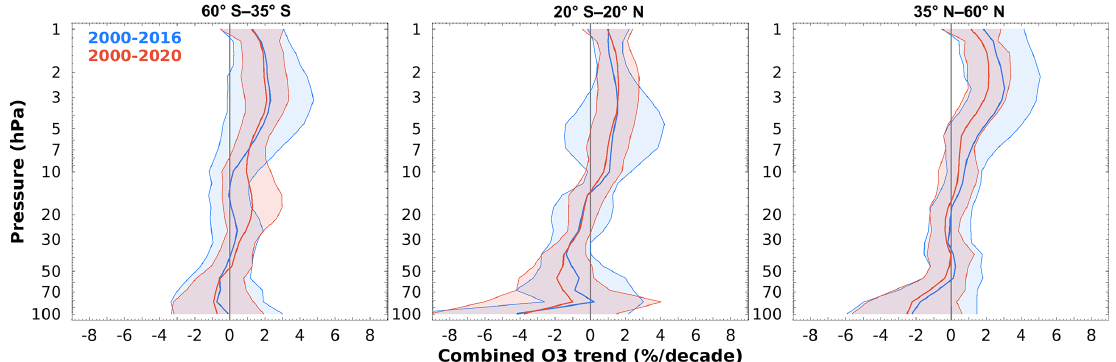
Figure 3. Combined post-2000 ozone profile trend estimates and uncertainties (2 σ ) from the seven merged satellite records (below the 50hPa level: five records, see text) for latitude bands 60–35 ◦ S (a) , 20 ◦ S–20 ◦ N (b) and 35–60 ◦ N (c) as for Fig. 2. Red (blue) solid line and light red (blue) shaded areas indicate LOTUS22 (LOTUS19) trend values and